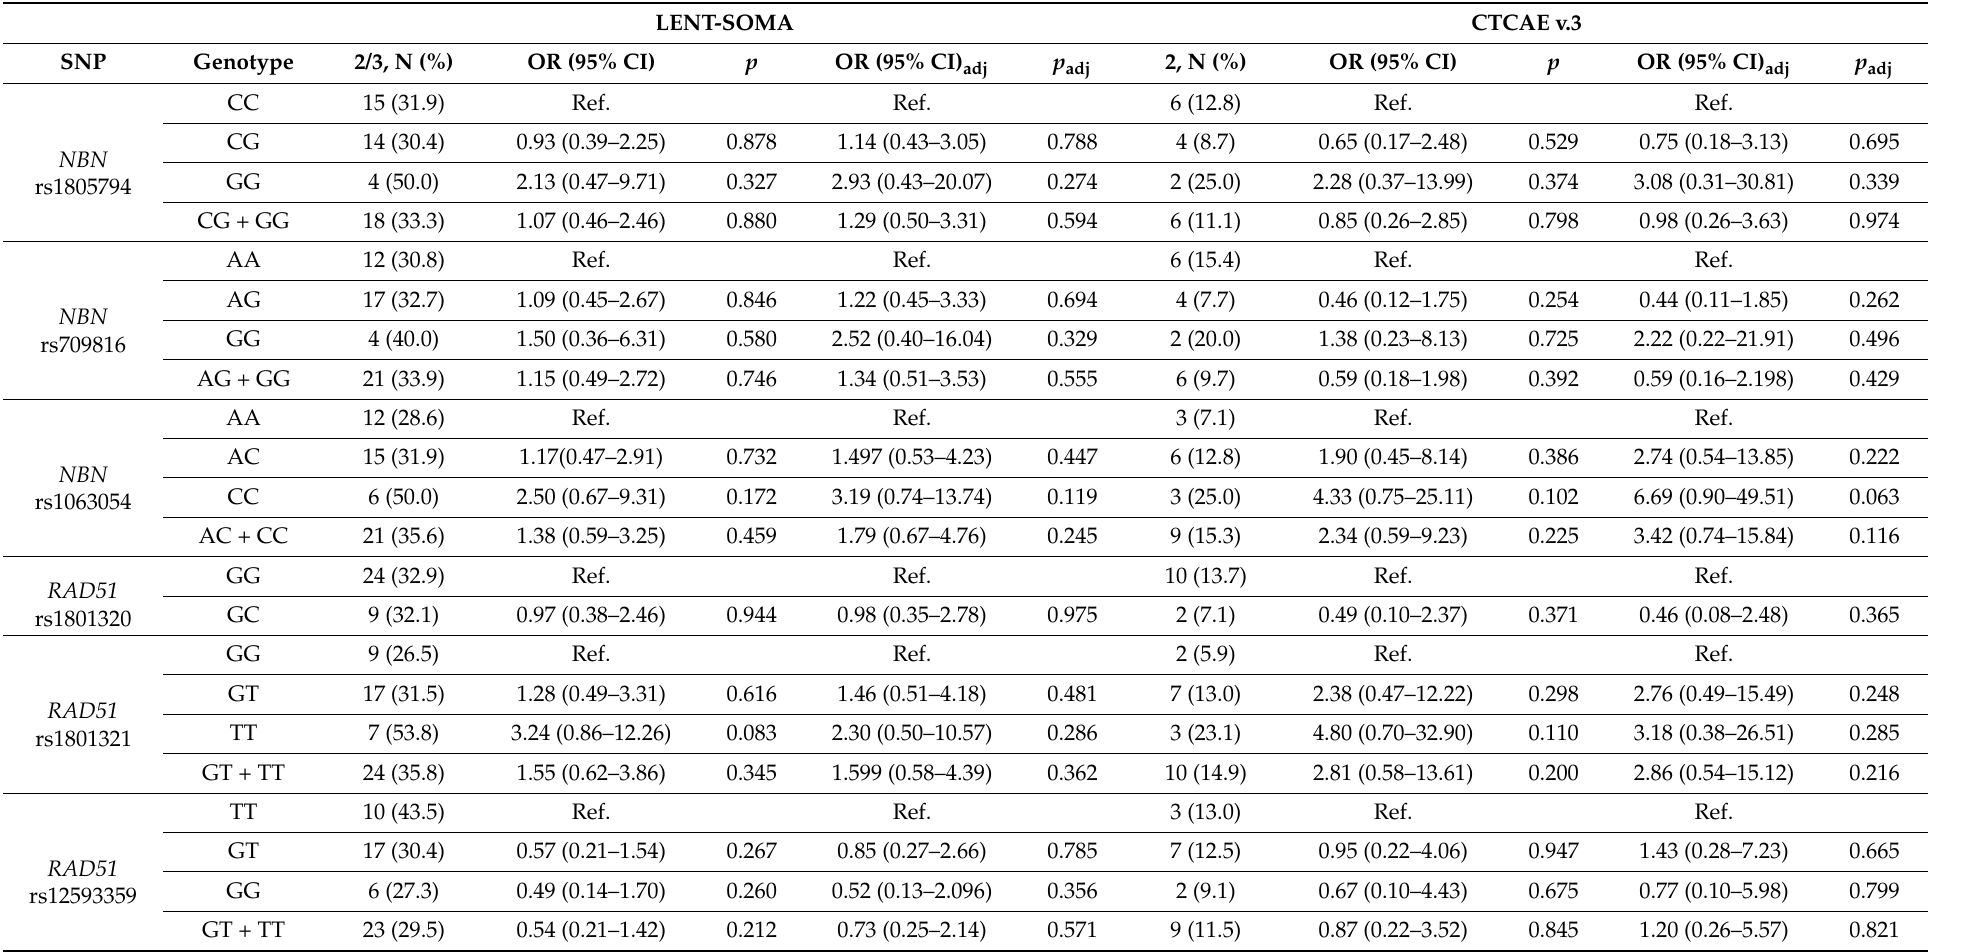
Table 7. Association of selected polymorphisms in HRR genes with late skin adverse events. LENT-SOMA CTCAE